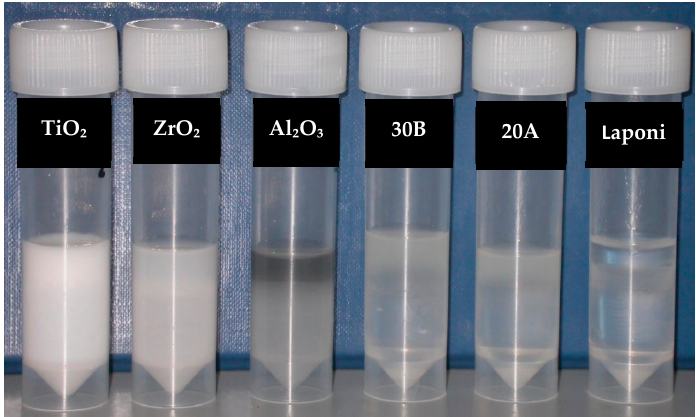
Figure 10. Particles subsequent to silane treatment, method II, mixed with monomer and stored for one hour from left to right; silane treated TiO 2 , ZrO 2 , Al 2 O 3 , Closite 30B, Closite 20A and laponite.